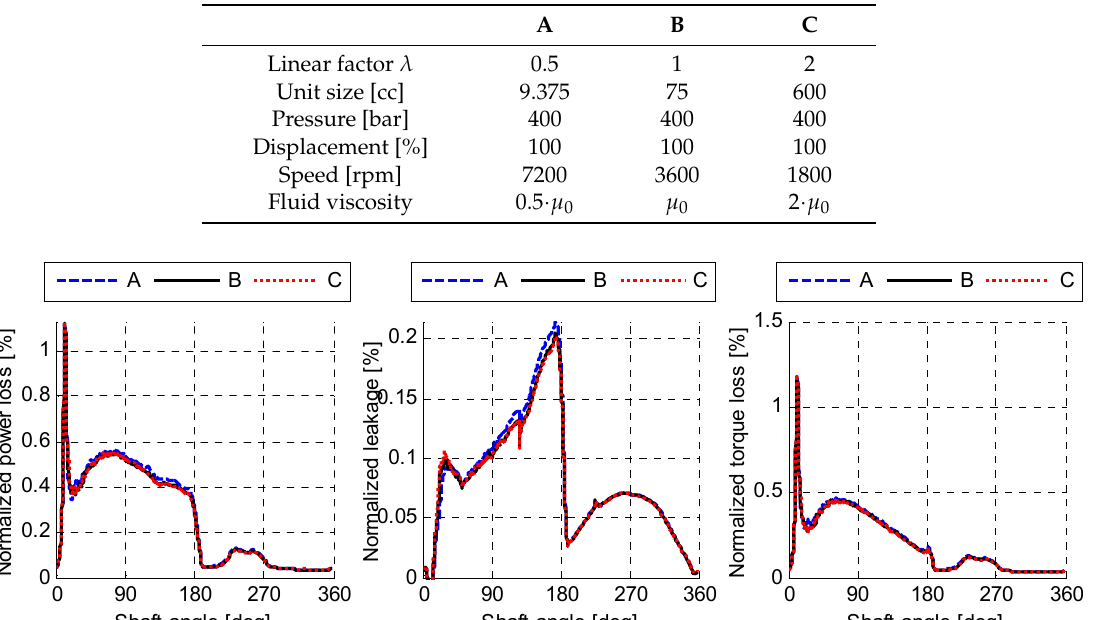
Figure 10. Normalized piston/cylinder interface performance comparison for different sizes.